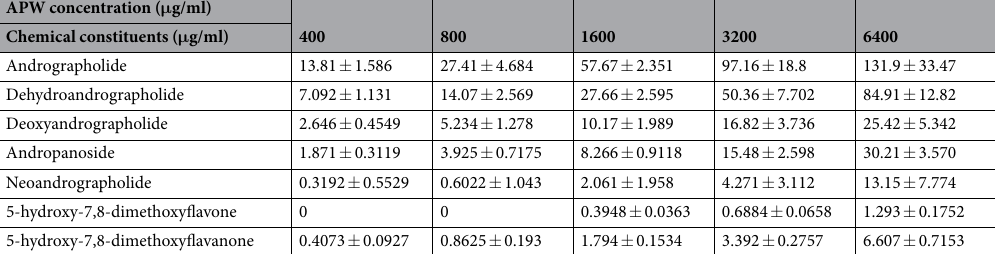
Table 1. The content of seven chemical constituents found in absorbed AP components from 400–6400 μ g/ml APW. Chemical constituents of APW detected and quantified in the buffer from the basolateral side of intestinal Caco-2 cell monolayer. Data are expressed as the mean ± S.D. of three independent